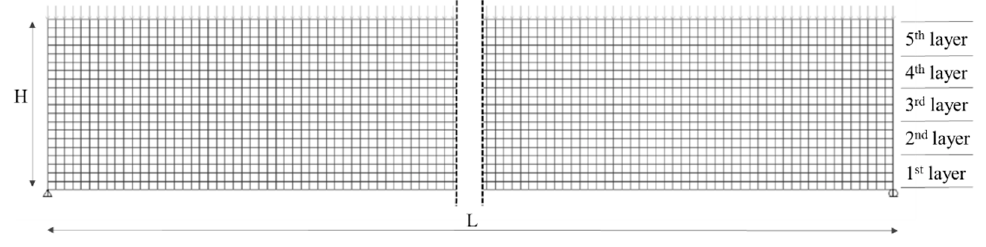
Figure 5. 2D-shell model of CLT panels.